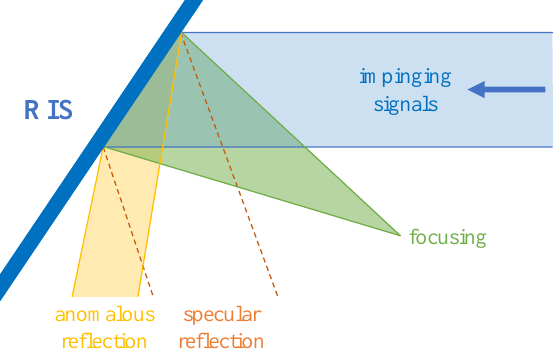
Figure 2. RIS behaviors: anomalous reflection (including specular reflection) and focusing.